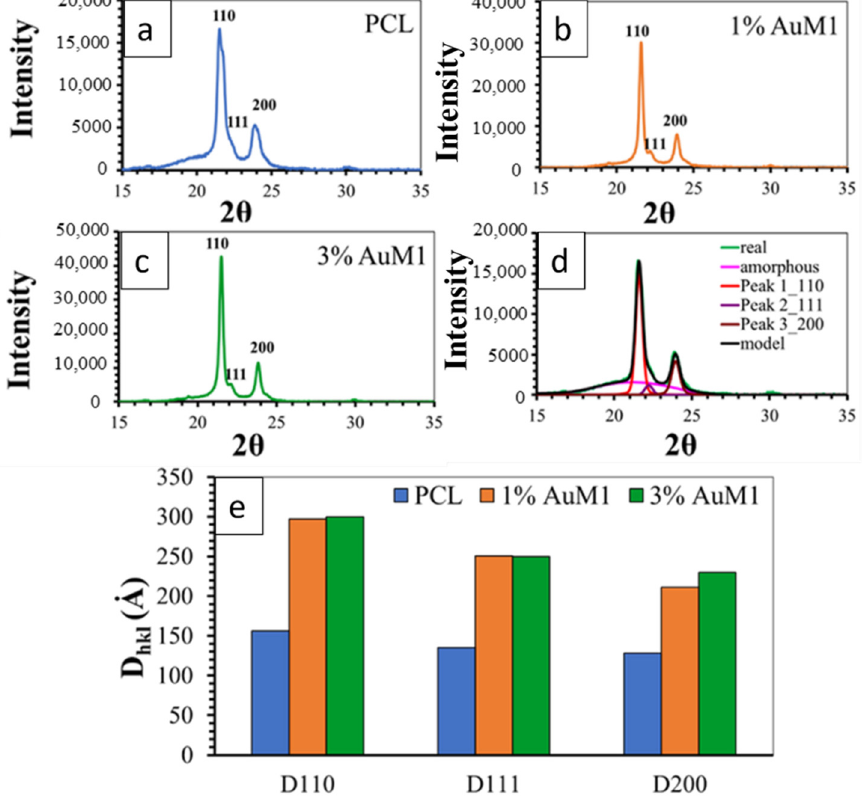
Figure 12. XRD spectra of ( a ) PCL; ( b ) 1%AuM1; ( c ) 3%AuM1; ( d ) Deconvolution Procedure and ( e ) crystallite size.